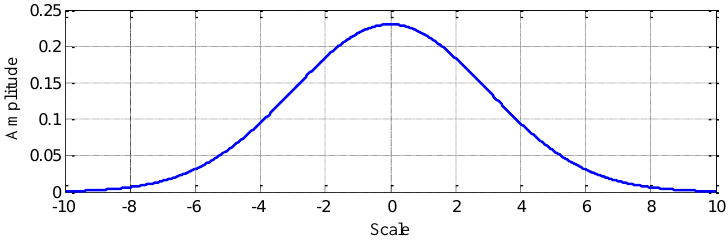
Figure 6. Shape of Gaussian kernel function.